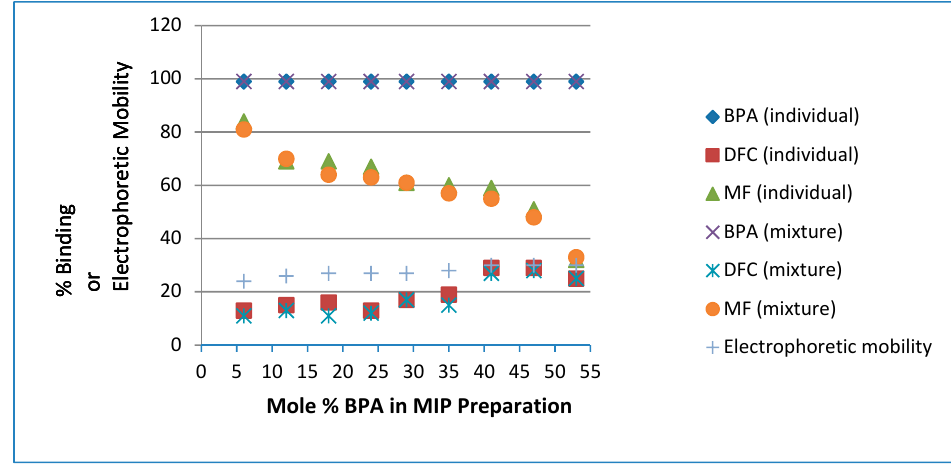
Figure 1. Percent binding results of bisphenol A (BPA), diclofenac (DFC) and metformin (MF) (individually and in mixture) and electrophoretic mobility for each MIP prepared with a different mole % of BPA. For clarity, error bars are represented by the size of symbols.